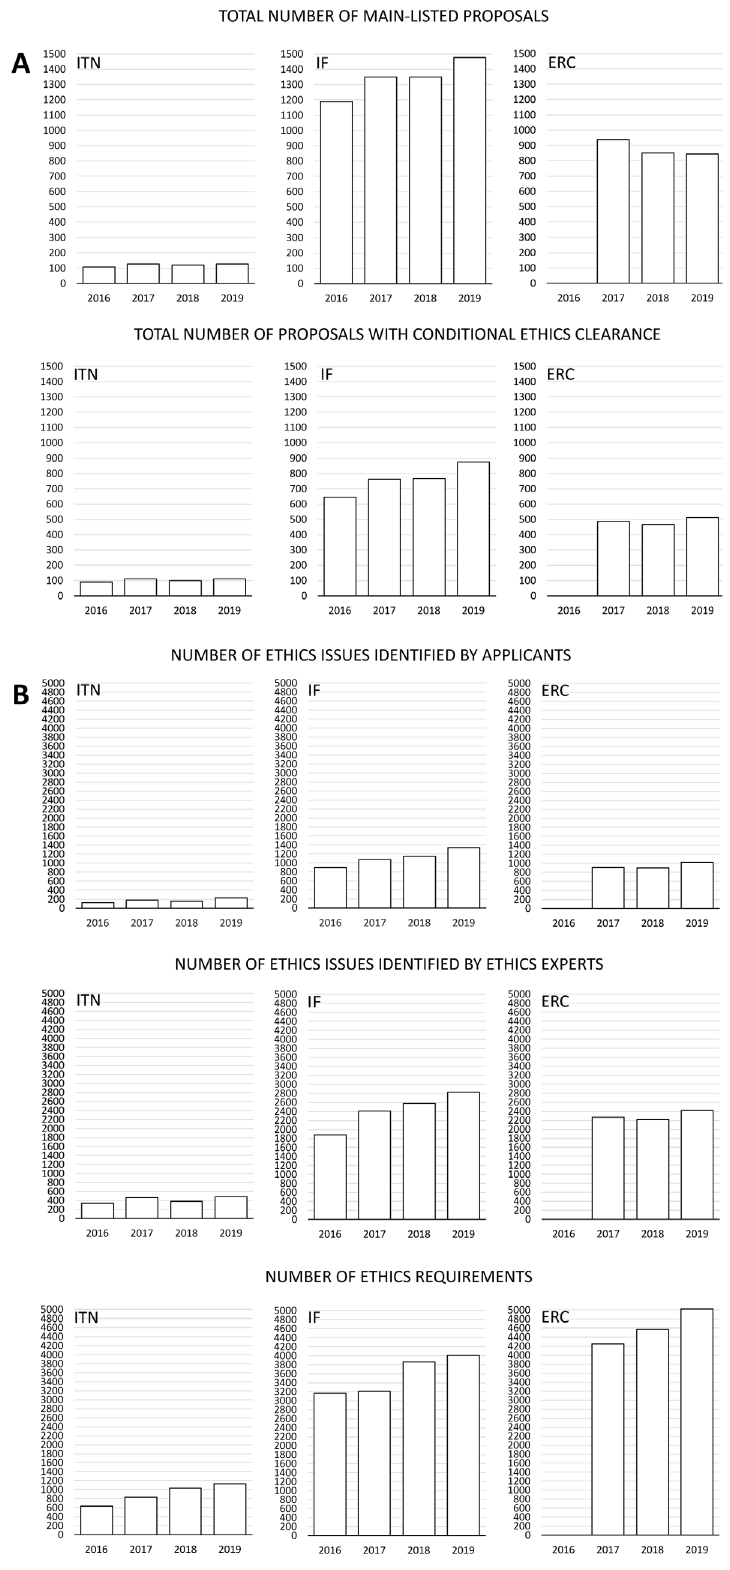
Figure 2. Distribution of the number of proposals, ethics issues and ethics requirements among different grant programmes from 2016 to 2019. ITN – Innovative Training Networks, IF – Individual Fellowships, ERC – European Research Council grants. The data are from years available in the SEP tool of the European